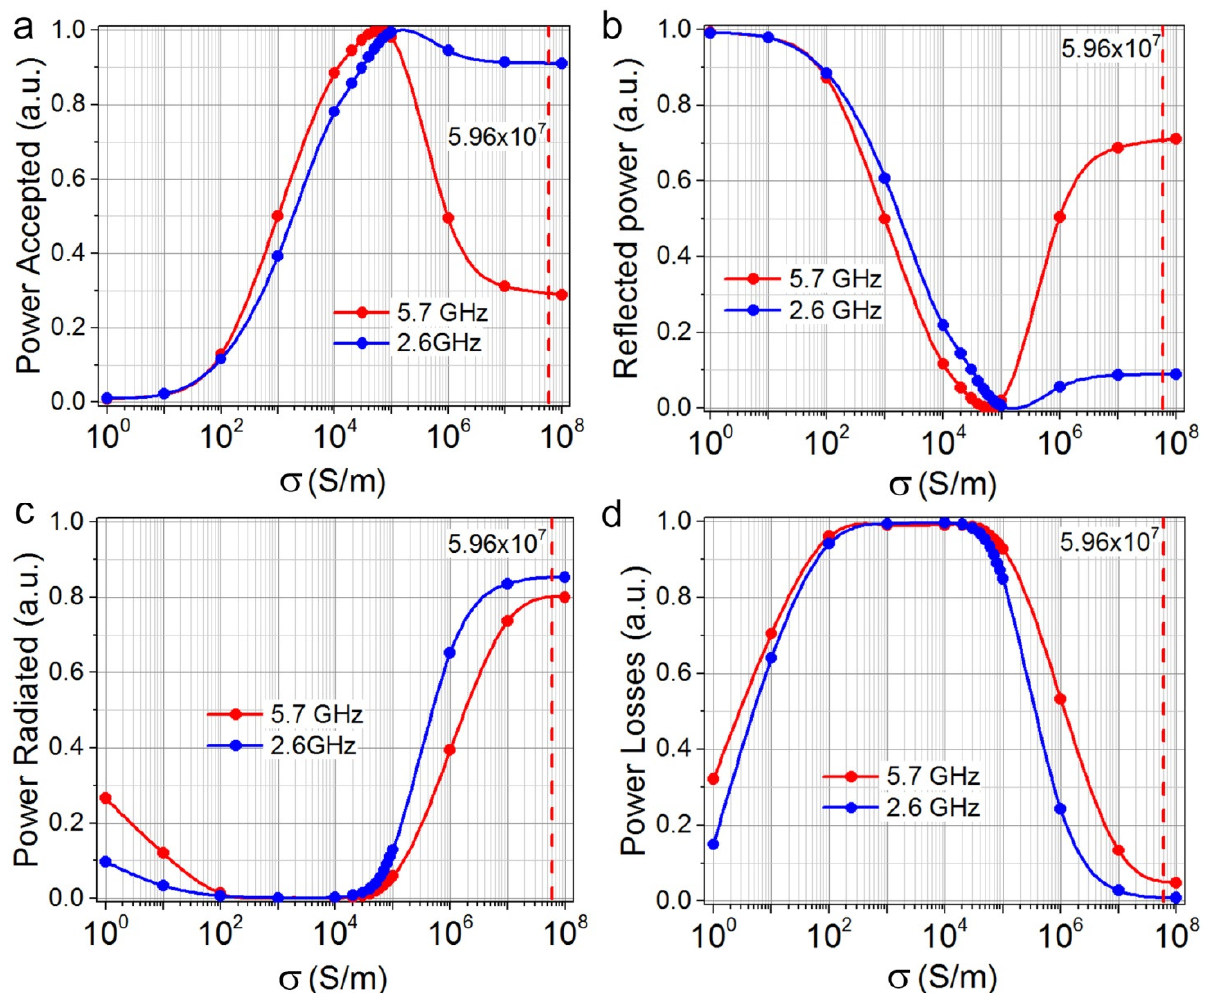
Figure 4. ( a , b ) Calculated dependence of the normalized powers in a two-sided symmetrical dipole of the ACu antennas versus the specific conductivity. The accepted and reflected powers are normalized to the incoming power value. ( c , d ) The calculated distribution of the power received by the AGr antenna depending on the specific conductivity. The powers are normalized to the accepted power value. The vertical line in the figures corresponds to the specific conductivity of copper: 5.96 × 10 7 S/m.